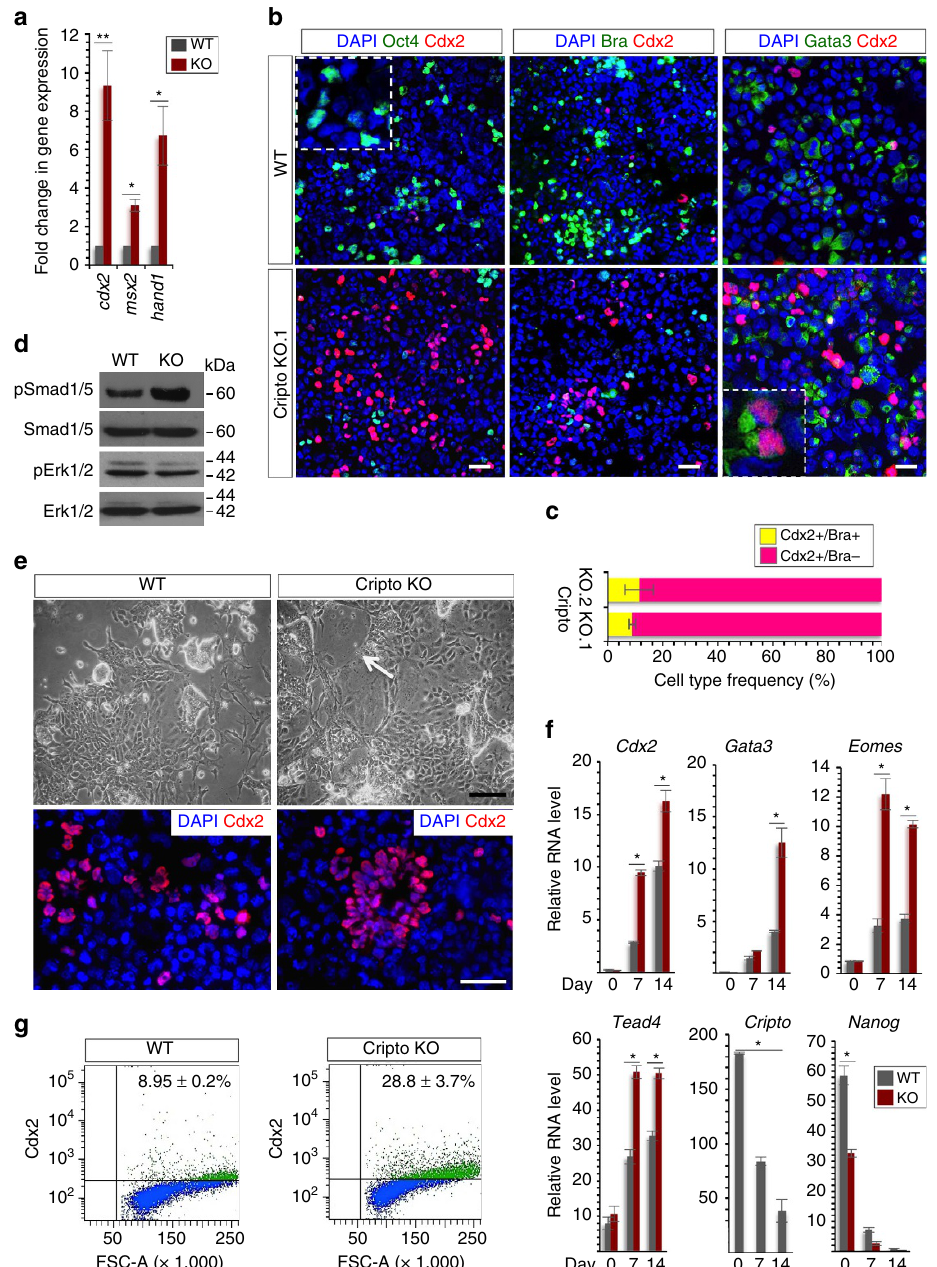
Figure 5 | Cripto depletion attenuates ESC differentiation potential towards embryonic lineages in vitro . ( a ) qPCR analysis of Cdx2 , Msx2 and Hand1 trophoblast markers in WTand Cripto KO ESC - EpiSC transition (day 6). Data are shown as fold change compared with ESCs after normalization to Gapdh and are mean ± s.e.m. ( n ¼ 3; * P o 0.01). ( b ) Representative pictures of Oct4/Cdx2, Bra/Cdx2 and Gata3/Cdx2 double immunostaining of F/A WT and Cripto KO (clone KO.1) cytospinned cells. Inserts are higher magnification images of selected areas. Nuclei were stained with 4,6-diamidino-2-phenylindole (DAPI). Scale bar, 75 m m. ( c ) Quantification of Cdx2 þ /Brachyury ± cells distribution. Data are expressed as percentage over total number of Cdx2 þ cells ( n E 300) on two independent Cripto KO ESC clones (KO.1 and KO.2) and are mean ± s.e.m. ( n ¼ 3). ( d ) Western blot analysis of pSmad1/5 and pErk1/2 protein levels in F/A WT and Cripto KO cells. Smad1/5, Erk1/2 were used as loading controls. ( e ) Photomicrographs of TSC colonies (top panels) and Cdx2 immunostaining in cytospinned cells (bottom panels) (scale bar, 75 m m) generated by WTand Cripto KO ESCs. White arrow indicates a trophoblastic giant cell (scale bar, 100 m m). ( f ) qPCR analysis of TE and pluripotency markers at different time points of WTand Cripto KO TSC differentiation. Relative RNA level was normalised to Gapdh ; data are mean ± s.e.m. ( n ¼ 3; P* o 0.01). ( g ) FACS-based quantification of Cdx2-positive cells at 2 weeks of ESC to TSC differentiation. Data are mean ± s.e.m. ( n ¼